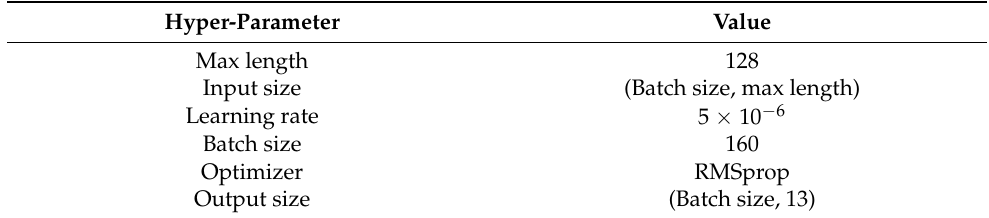
Table 4. Parameters of CNN-based classifier for music genre classification.